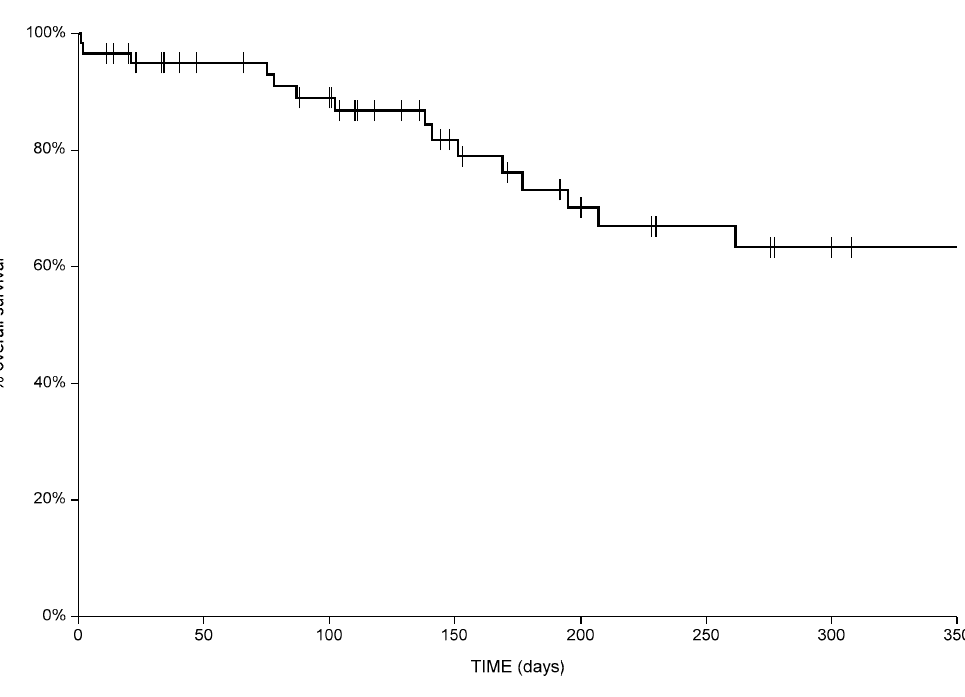
Figure 4. Overall survival for the total cohort of patients.